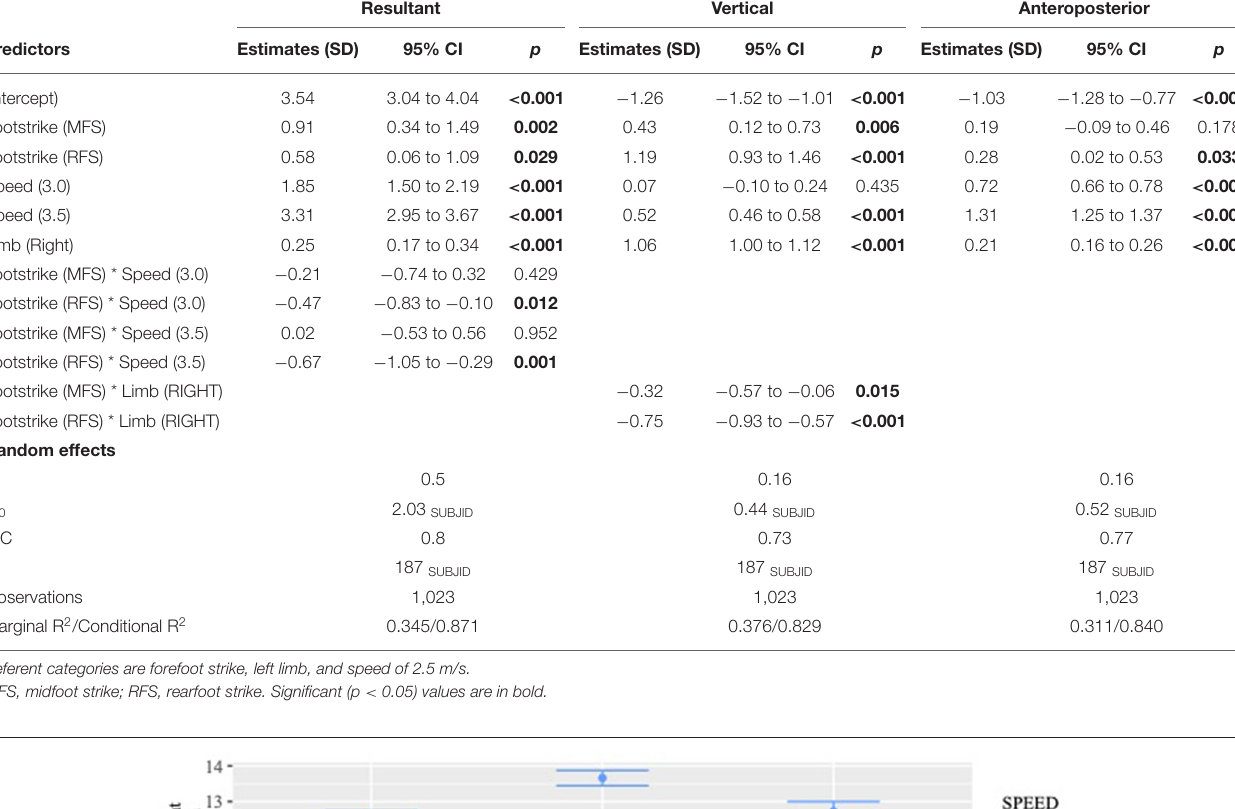
TABLE 4 | Final standardized models for the effect of foot strike on peak resultant, vertical, and anteroposterior acceleration controlling for speed and limb. Resultant Vertical Anteroposterior